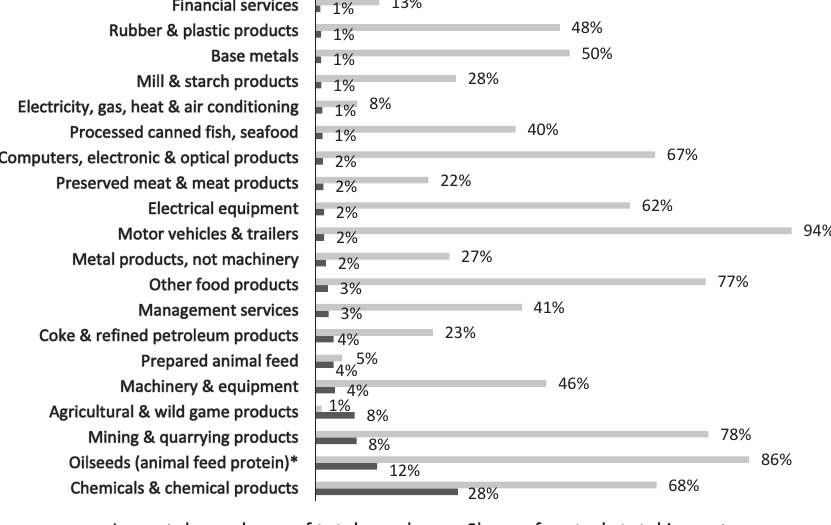
Fig. 4. Primary agriculture dependency on imports for the total supply of direct and indirect inputs into the sector *In the category of “Vegetable oils & animal